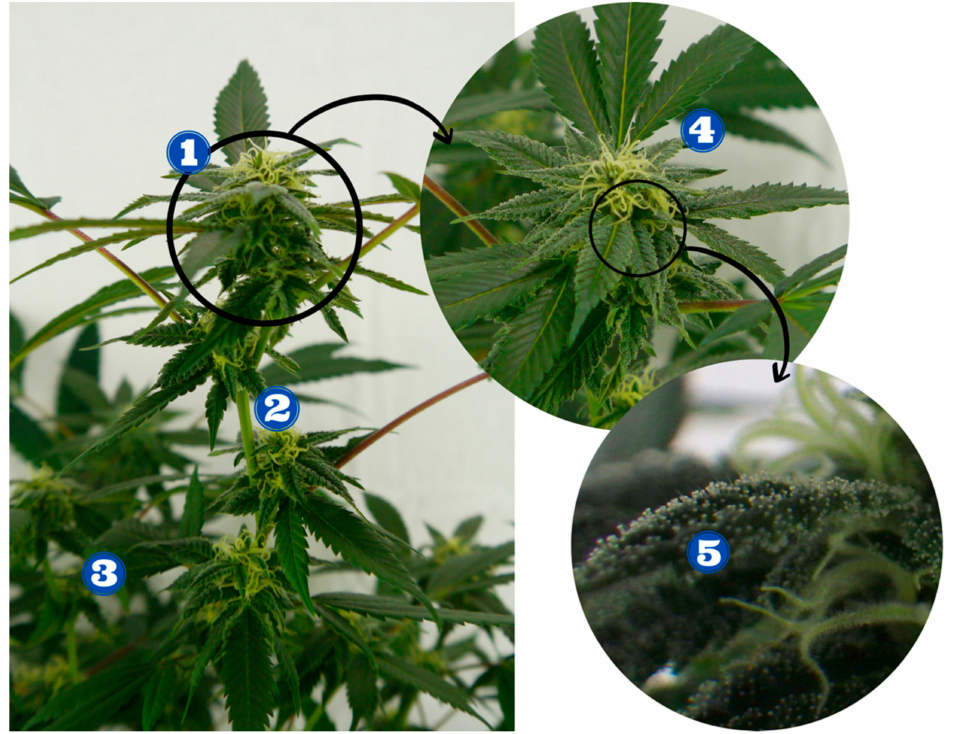
Figure 1. A cannabis plant: ( 1 ) mature bud/calyx/inflorescence, ( 2 ) stem, ( 3 ) fan leaves, ( 4 ) sugar leaves, and ( 5 ) trichomes (images were taken by M. Neufeldt and are used with